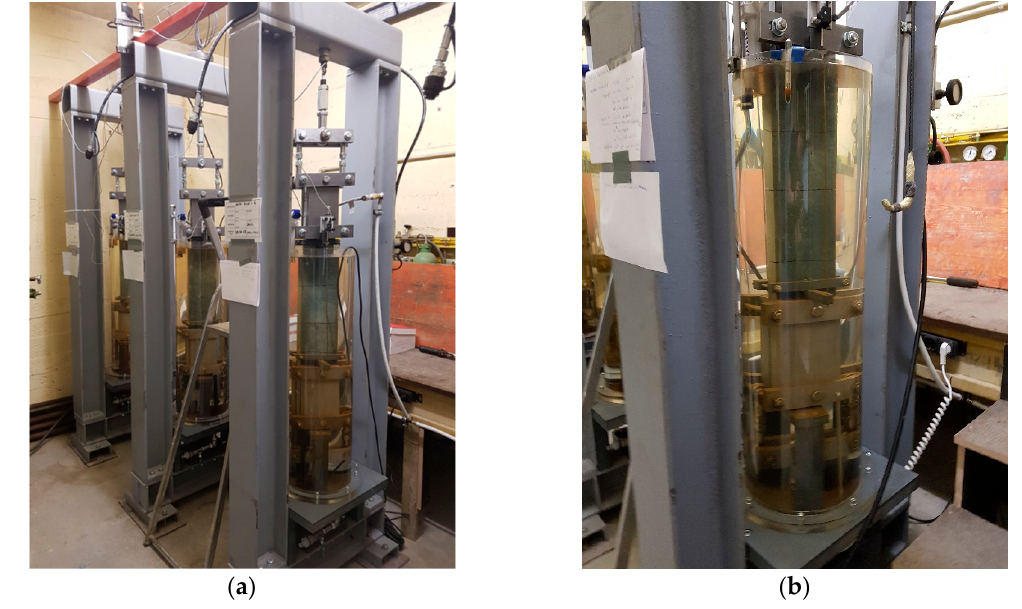
Figure 3. ( a ) Long-term durability test rigs; ( b ) Test specimen under exposure.